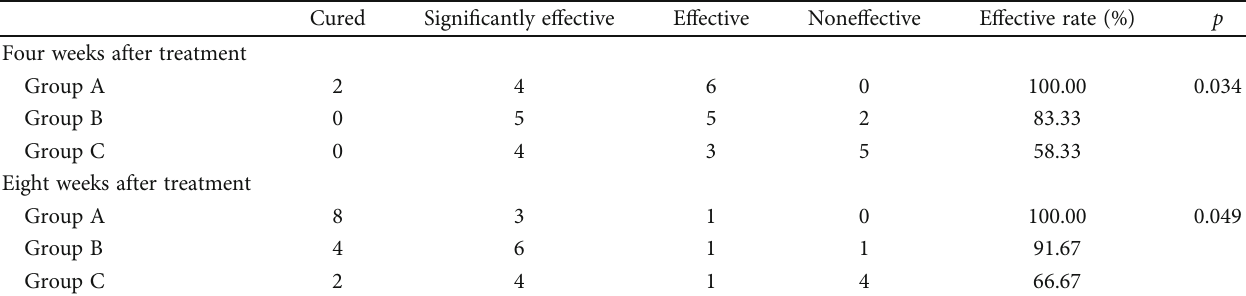
Table 2: Comparison of clinical e ffi cacy among three